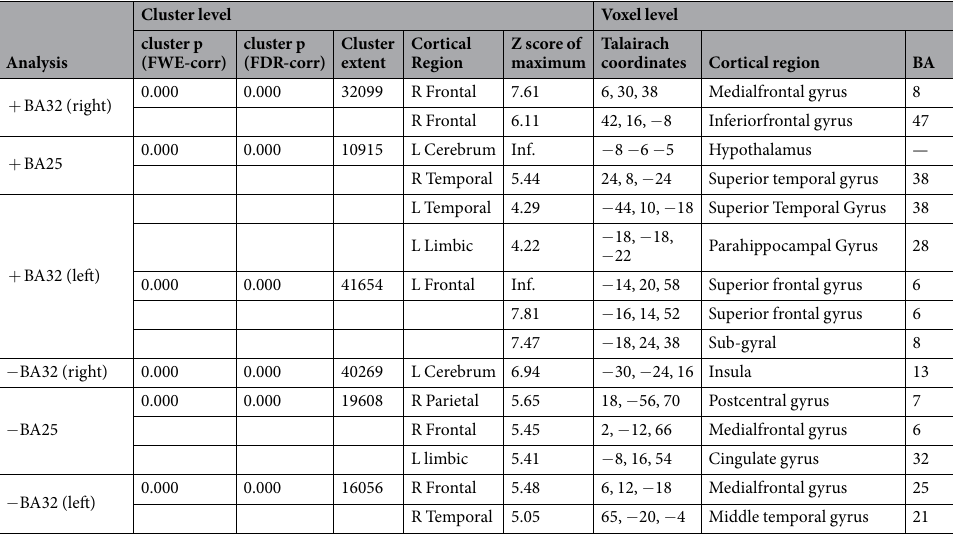
Table 4. Regression analysis showing the areas of increased (positive correlation, + ) or decreased (negative correlation, − ) 18 F FDG brain uptake related to Brodmann areas 32 (right, left) and 25. In the ‘cluster level’ section on left, the number of voxels, the corrected P value of significance and the cortical region where the voxel is found, are all reported for each significant cluster. In the ‘voxel level’ section, all of the coordinates of the correlation sites (with the Z-score of the maximum correlation point), the corresponding cortical region and BA are reported for each significant cluster. L, left; R, right; BA, Brodmann’s area. In the case that the maximum correlation is achieved outside the grey matter, the nearest grey matter (within a range of 5 mm) is indicated with the corresponding